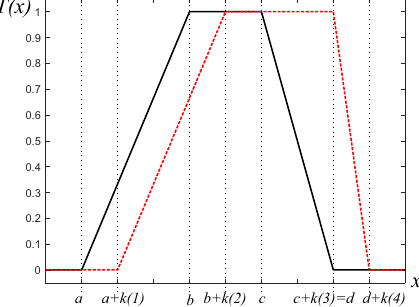
Figure 9. Trapezoidal membership function adjustment.